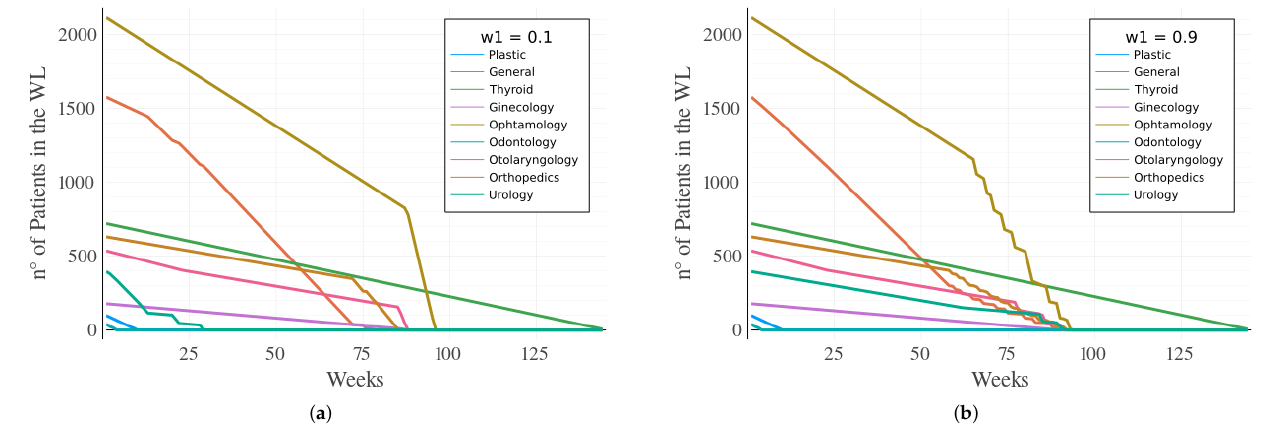
Figure 3. Patients in the waiting list per week with ( a ) w 1 = 0.1 and ( b ) w 1 =